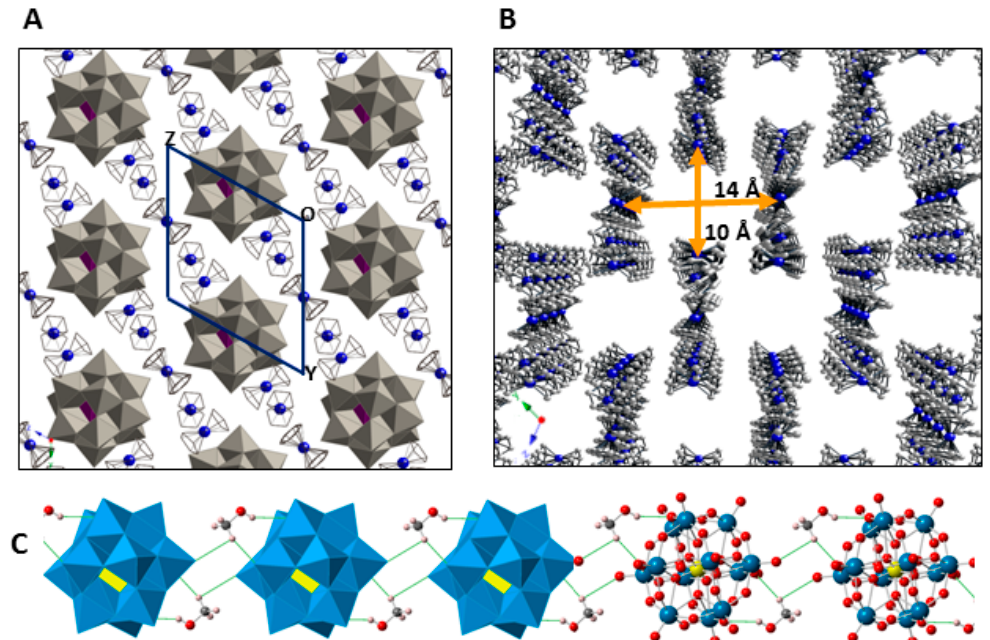
Figure 5. View of the crystal packing of 1 along the [100] direction ( A ). Channels formed by the organometallic sub-lattice. ( B ) Hydrogen atoms and methanol molecules are omitted for clarity. Hybrid polyhedral and ball & sticks representation of the hydrogen-bonded, methanol-bridged POM chain running along the [100] direction ( C ). Table 2. Geometrical parameters (Å, °) of the intermolecular π - π interactions in 1 . π - π Interactions Stacking